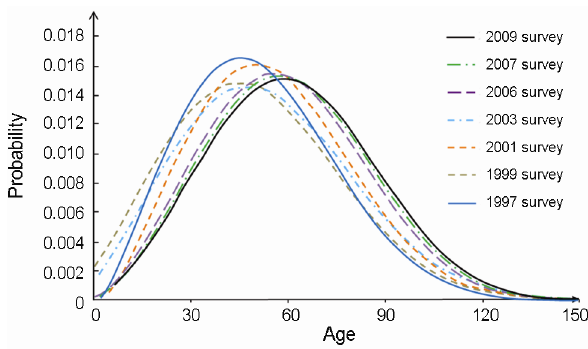
Fig. 1. The U.S. residential service life distributions (Modified on Aktas, Bilec